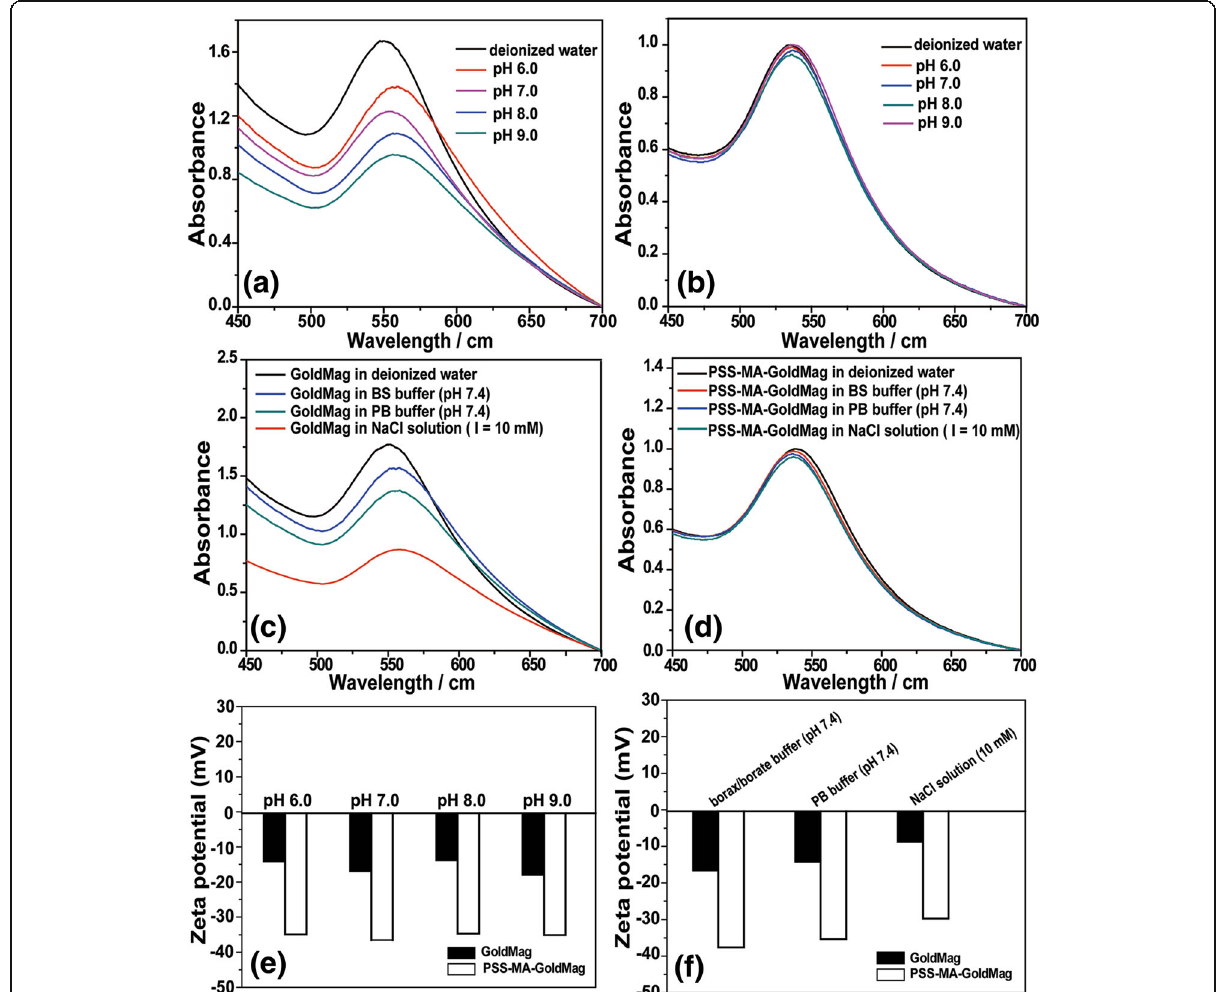
Fig. 3 a The SPR spectra of GoldMag in borax/borate buffer (0.02 mol/L) with different pH values ranging from 6.0 to 9.0. b The SPR spectra of PSS-MA-GoldMag in borax/borate buffer (0.02 mol/L) with different pH values ranging from 6.0 to 9.0. c The SPR spectra of GoldMag suspended in borax/borate buffer (0.02 mol/L, pH 7.4), PB buffer (0.2 mol/L, pH 7.4) and in a electrolyte solution. d The SPR spectra of PSS-MA-GoldMag sus- pended in borax/borate buffer (0.02 mol/L, pH 7.4), PB buffer (0.2 mol/L, pH 7.4) and in electrolyte solution. e The change of zeta potential of GoldMag suspended in borax/borate buffer (0.02 mol/L) with different pH values ranging from 6.0 to 9.0. f The change of zeta potential of Gold- Mag suspended in borax/borate buffer (0.02 mol/L, pH 7.4), PB buffer (0.2 mol/L, pH 7.4), and in electrolyte